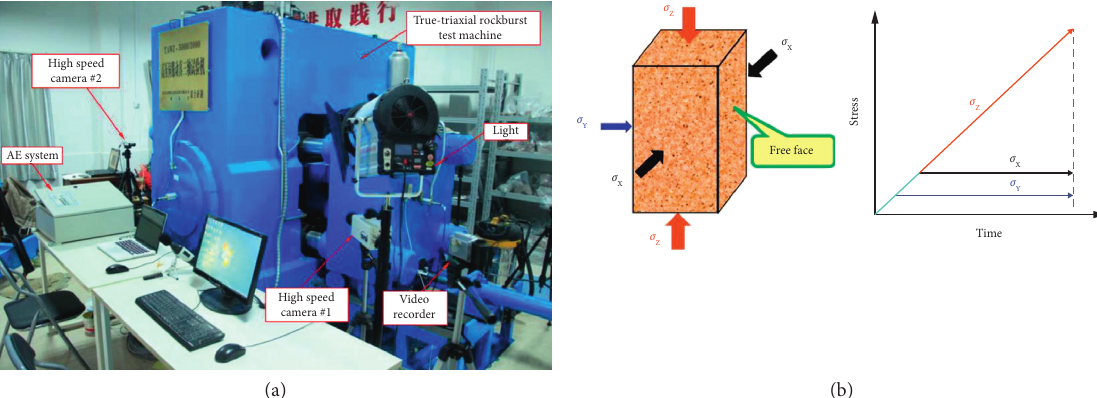
Figure 16: Rockburst test system and loading mode: (a) physical picture; (b) stress path